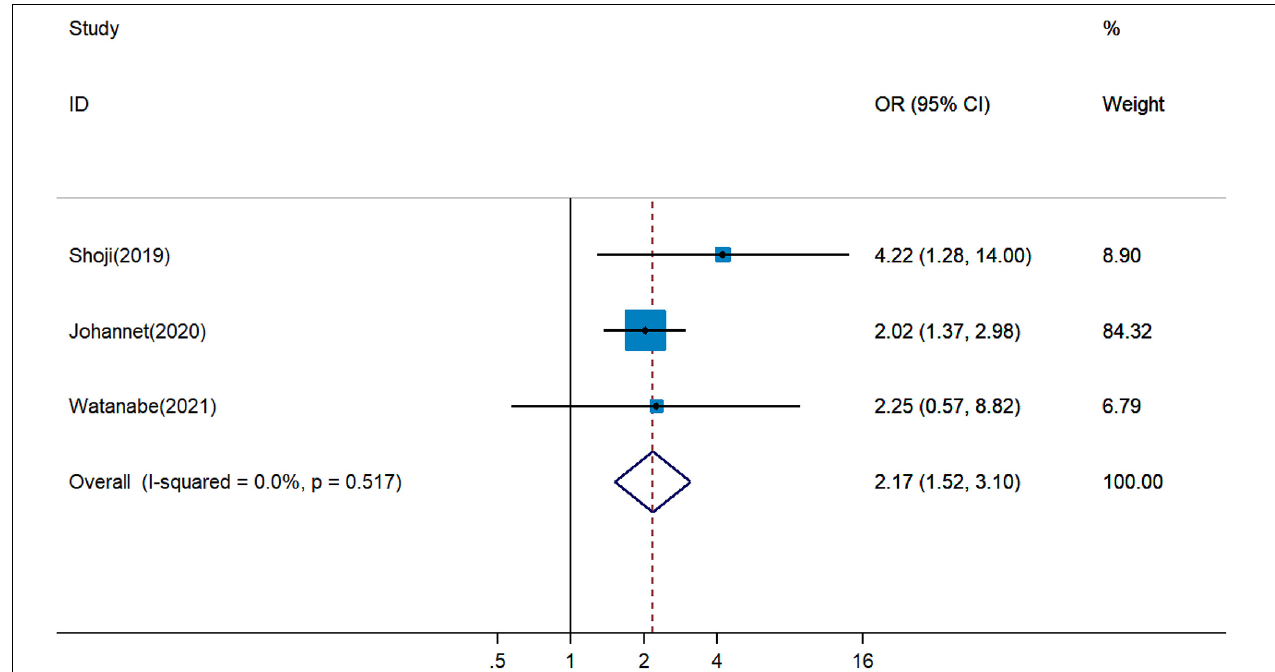
FIGURE 7 | Funnel plots of studies on the association between PLR and overall survival in patients treated with immune checkpoint inhibitors.